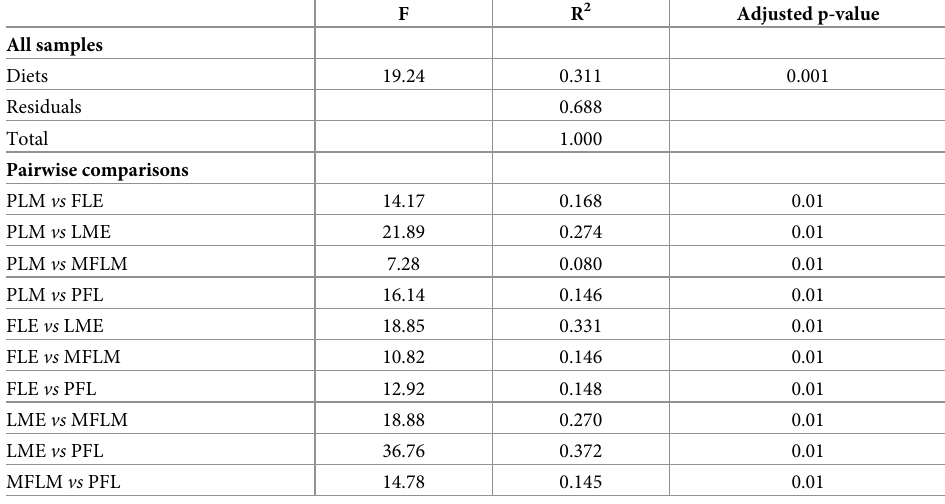
F = F value by permutation. R 2 = shows the percentage of variation explained by diets; p-values were based on 999 permutations and were adjusted by Bonferroni